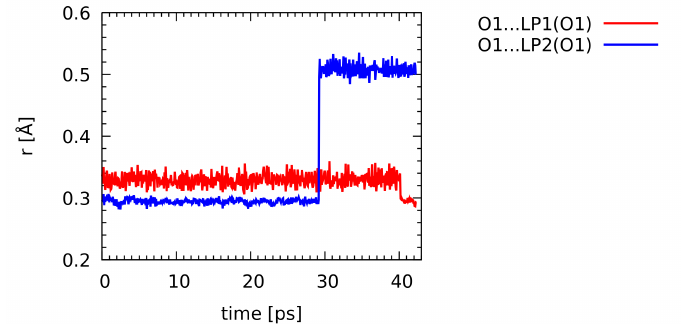
Figure 5. Distances between the O1 atom and its lone pairs centers (localized Wannier orbitals) along the CPMD trajectory. See Figure 2 for the atoms numbering